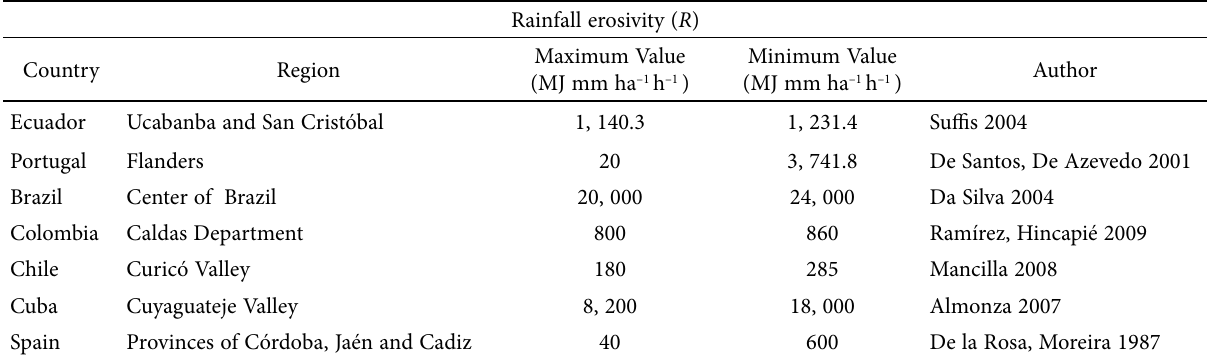
and R with other regions of the world (MJ mm ha –1 h –1 ) 1 2